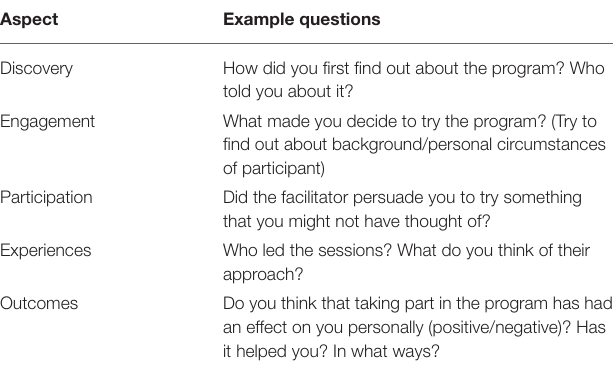
TABLE 3 | Overview of the semi-structured interview guide.